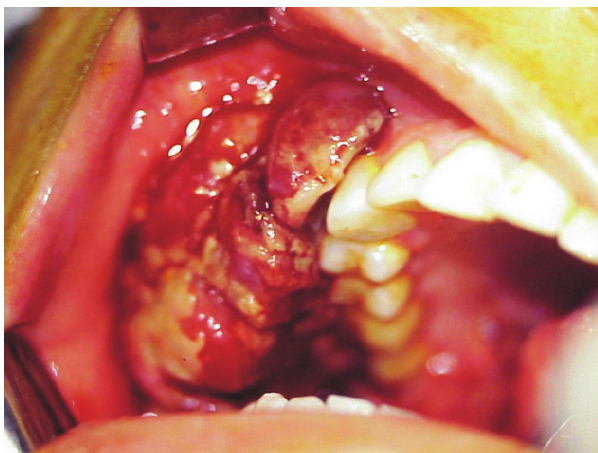
Figure 4 - HIV associated Kaposi´s